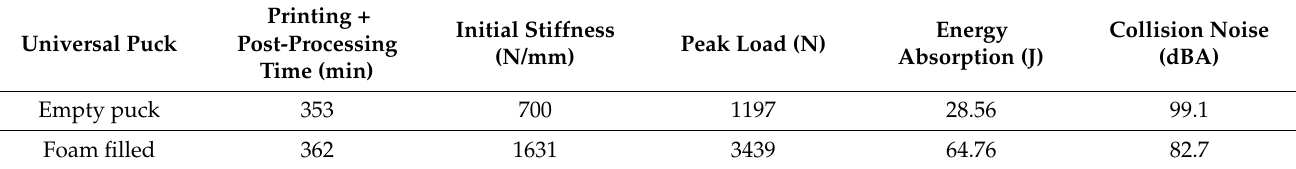
Table 5. Fabrication and mechanical properties comparison of the empty and foam-filled universal puck.